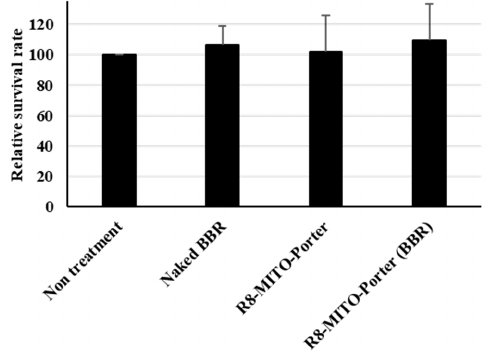
Figure 7. Evaluation of cell viability. After treatment with these samples, the medium was replaced, and the resulting suspension was incubated for 4 h. Cell viability was evaluated using PremixWST- 1 reagent. Relative cell viability was calculated by normalizing the cell viability for the nontreat- ment. Data are represented as the mean ± S.D. (n = 3). One-way ANOVA followed by